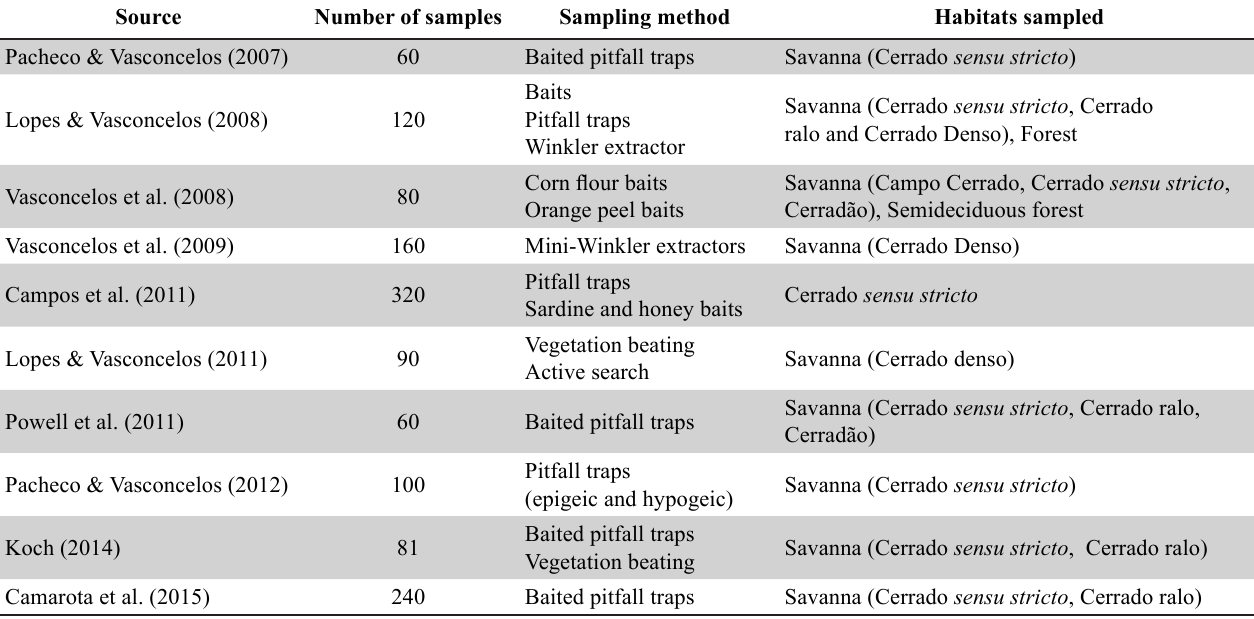
Table 1 . List of studies involving the ant fauna of the Panga Ecological Station, including sampling effort, sampling method and habitats